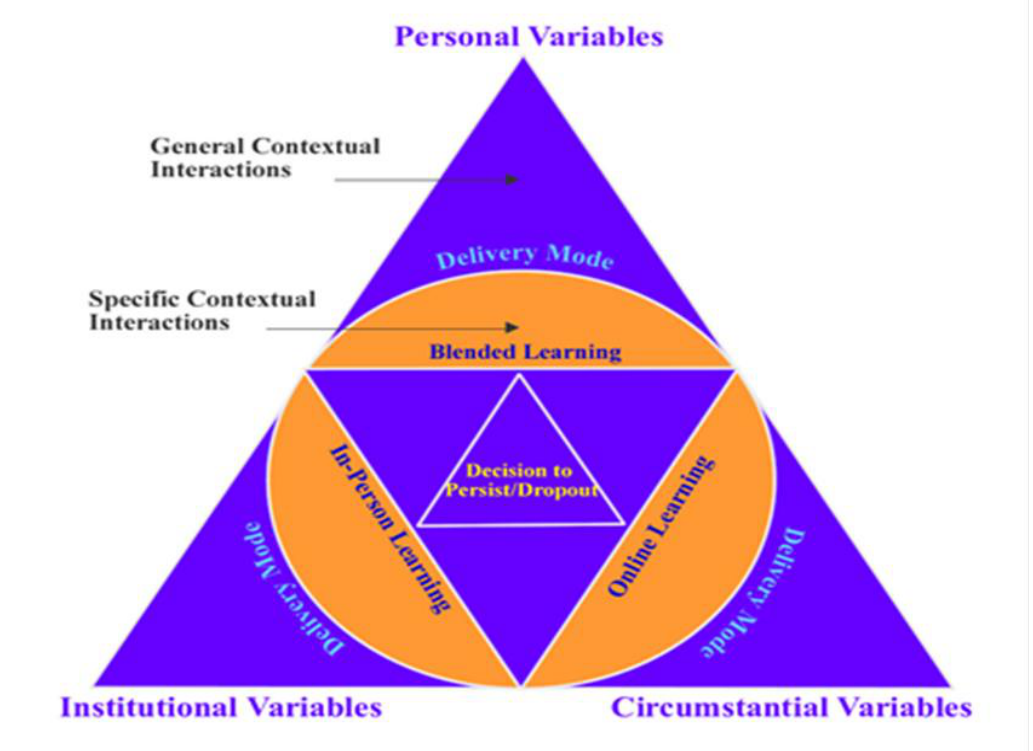
Figure 1. Sustainable retention model including e-learning. From “A model for sustainable student retention: A holistic perspective on the student dropout problem with special attention to e-learning,” by Z. L. Berge and Y. P. Huang, 2004, DEOSNEWS, 13 (5), p. 16. Reprinted with permission.